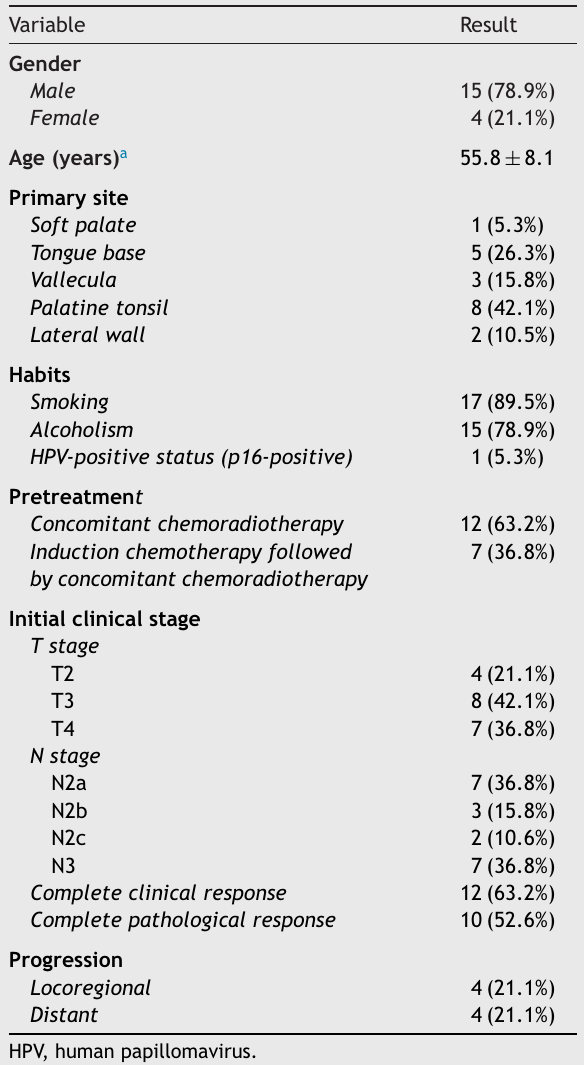
Descriptive data of patients included in this